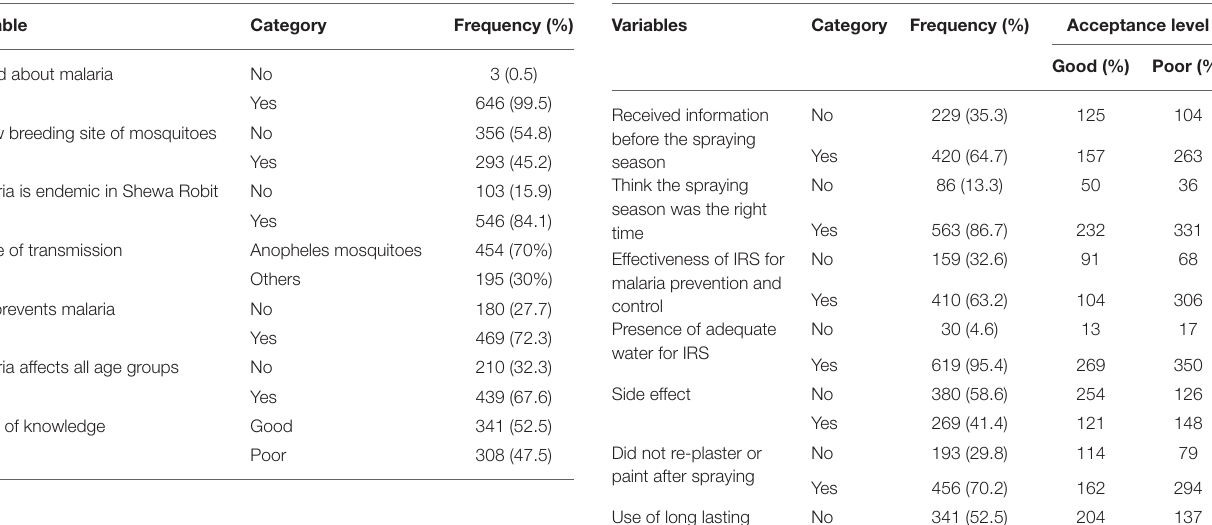
TABLE 3 | Perception ad practice toward IRS among communities of Shewa Robit town, North Eastern Ethiopia,